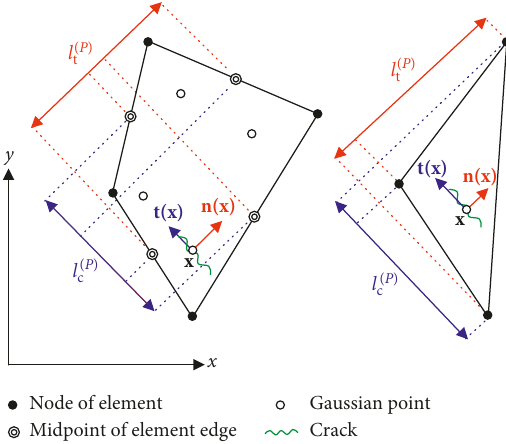
Figure 3: Proposed estimation of crack bandwidths.